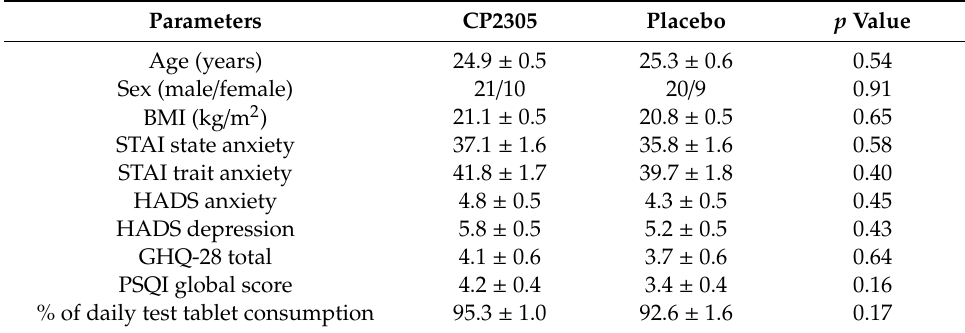
Table 2. Comparison of baseline characteristics between CP2305 and placebo